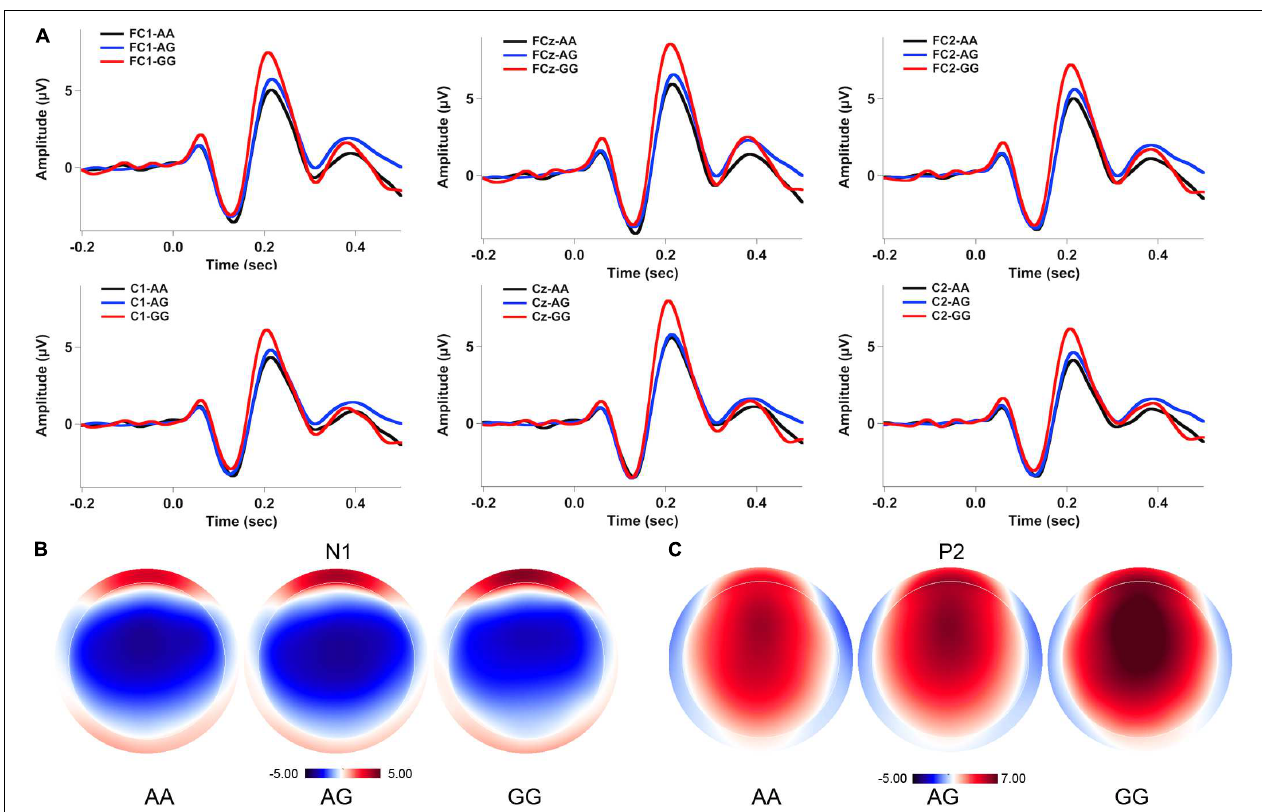
FIGURE 3 | Grand-averaged ERP waveforms (A) and topographical distributions of the N1 (B) and P2 (C) amplitudes in response to –200 cents pitch perturbations across the genotypes. The black, blue, and red solid lines represent cortical ERPs for the AA, AG, and GG genotypes, respectively.